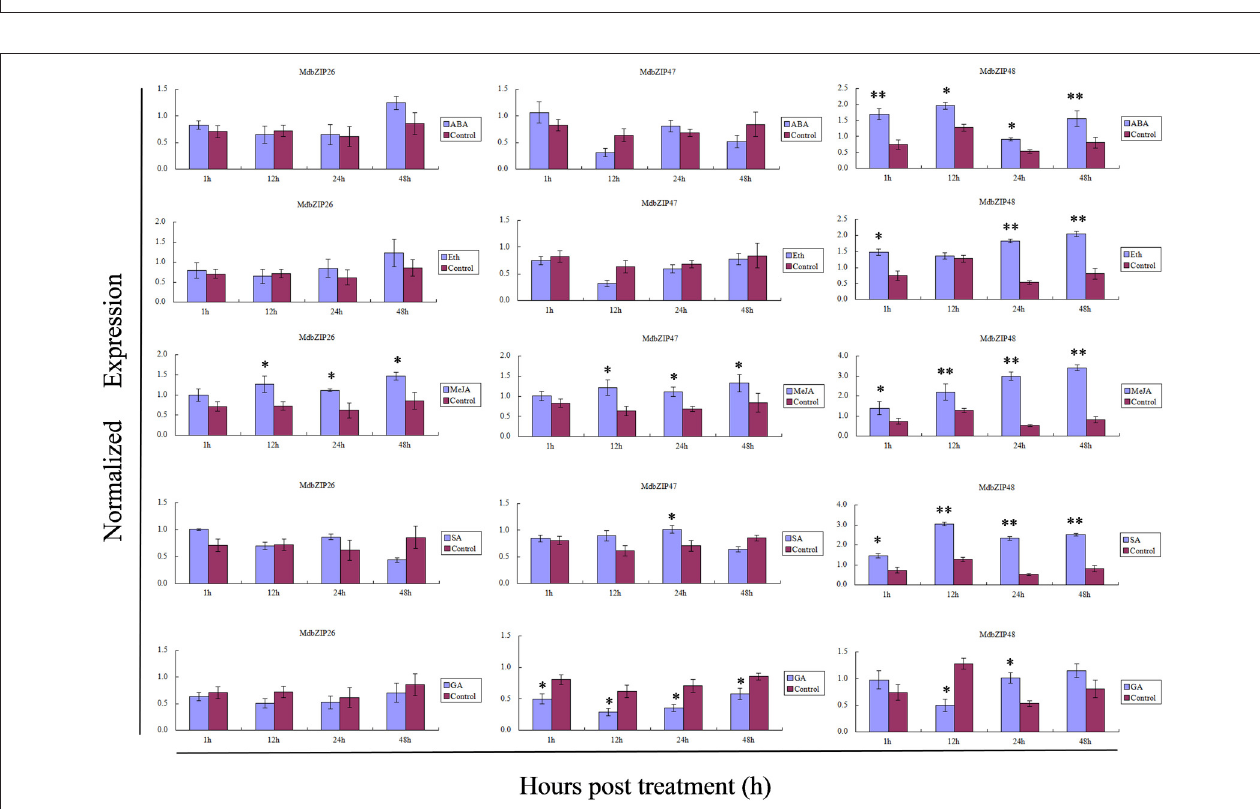
FIGURE 8 | Transcript levels in leaves of three randomly selected MdbZIP genes (MdbZIP26, MdbZIP47, MdbZIP48) following treatments with abscisic acid; ethylene; methyl jasmonic acid; salisylic acid; gibberellins., determined by quantitative real-time RT-PCR. The apple EF-1a gene was used as an internal control to normalize the data. The error bars were calculated based on three biological replicates. The data are shown as the mean values ± SD. * and ** indicate the corresponding gene signifcantly up- or down-regulated under the differential treatment by t- test ( * P < 0.05, ** P < 0.01).